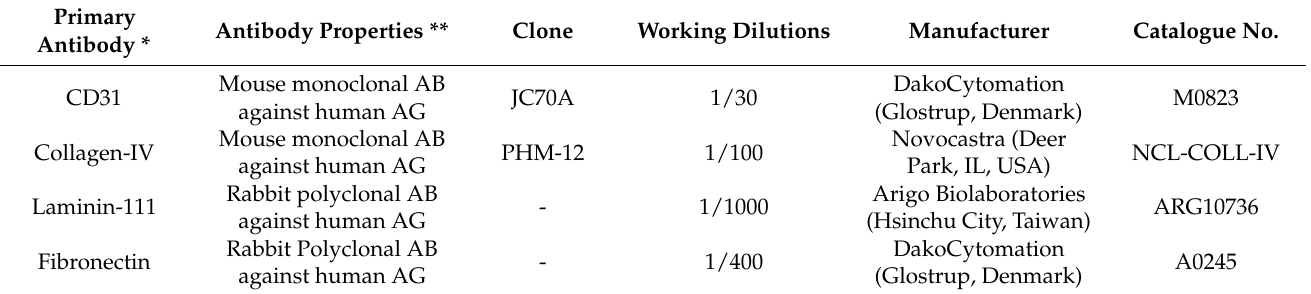
Table 1. Primary antibodies used in the present